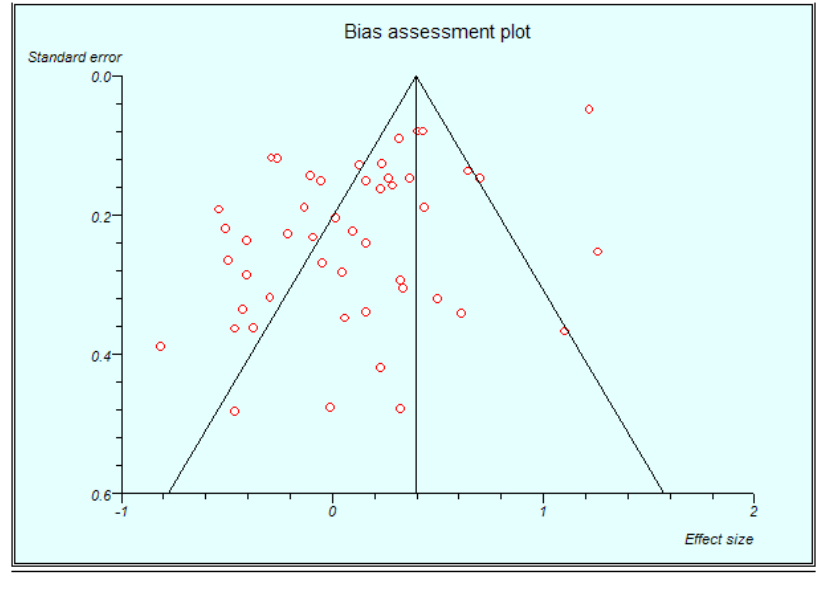
Figure 1. Bias Assessment Plot